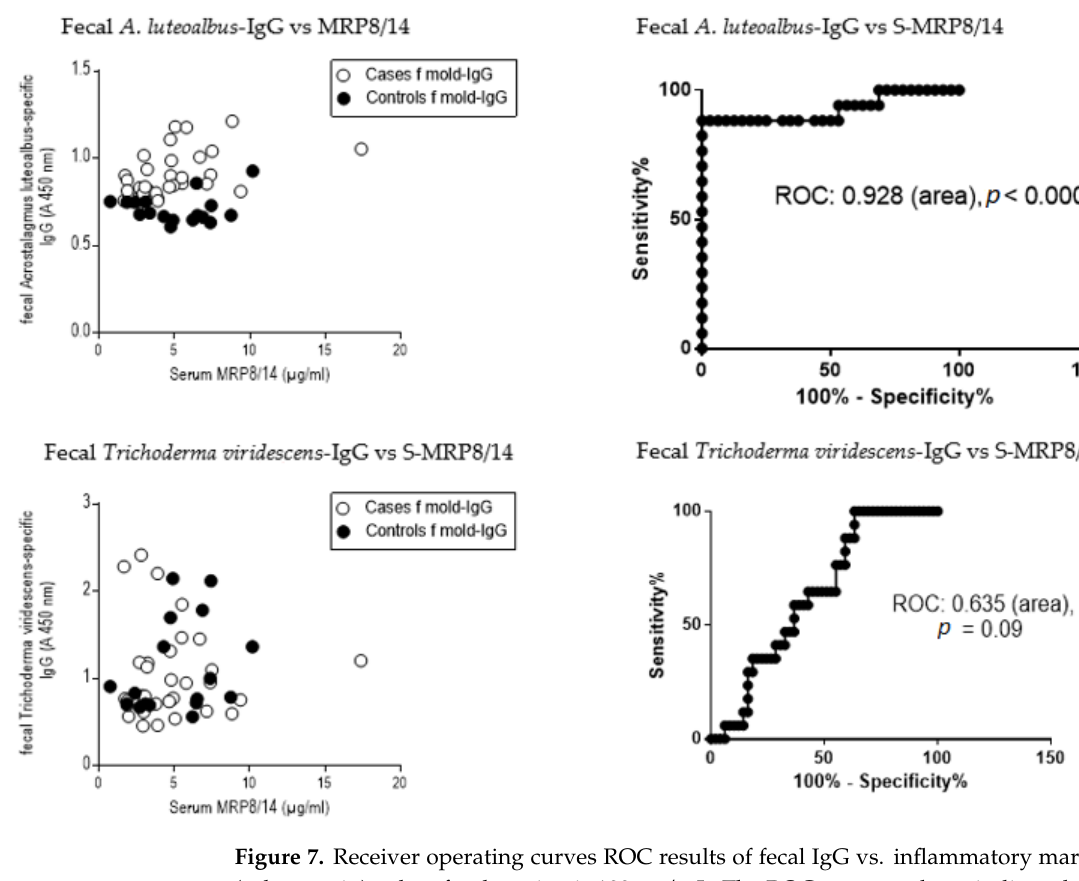
Figure 7. Receiver operating curves ROC results of fecal IgG vs. inflammatory marker MRP8/14 (calprotectin), when fecal coating is 100 µ g/mL. The ROC curve analyses indicated the diagnostic performance of the specific Ig against the subject’s inflammation status, as determined by MRP8/14 levels. The best resolution results of microbial-specific Igs are evident in Figure 5 and the poorest resolution result in Figure 3. The best resolution result of Figure 5 from the first row on the left (fecal A. luteoalbus -specific IgG) was plotted against the concentration of MRP8/14, a marker of inflammation, in exposed subjects (open circles) and controls (black circles). On the top right-side is the ROC curve with the specificity and sensitivity calculated. The lower row shows as an example of how the respective results of T. viridescens -specific fecal IgG results do not distinguish mold-exposed subjects from controls (Figure 2 right top), and the ROC curve value is in line with the conclusion that fecal T. viridescens -specific IgG results were of no value when evaluating whether the subject had been exposed to harmful toxins.